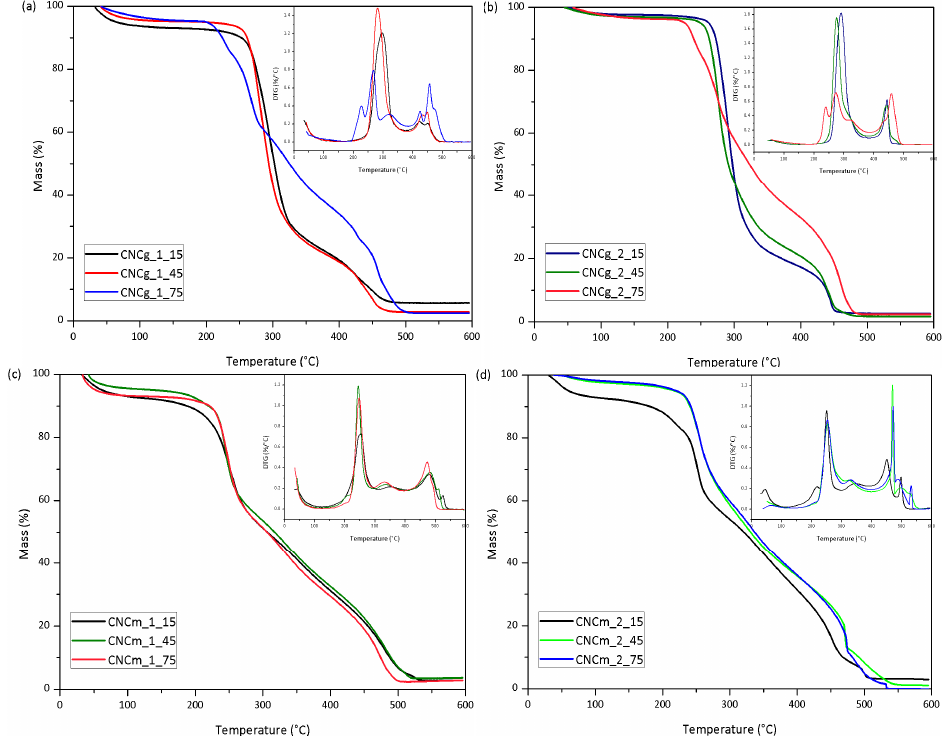
Figure 11. TG and DTG curves of CNCg obtained from ( a ) 1x and ( b ) 2x bleached gravata fiber; and CNCm obtained from ( c ) 1x and ( d ) 2x bleached macauba fiber; in synthetic air atmosphere and a × and ( d ) 2 × bleached macauba fiber; in synthetic air atmosphere and heating rate of 10°C/min. and CNCm obtained from ( c ) 1 a heating rate of 10 ◦ C /